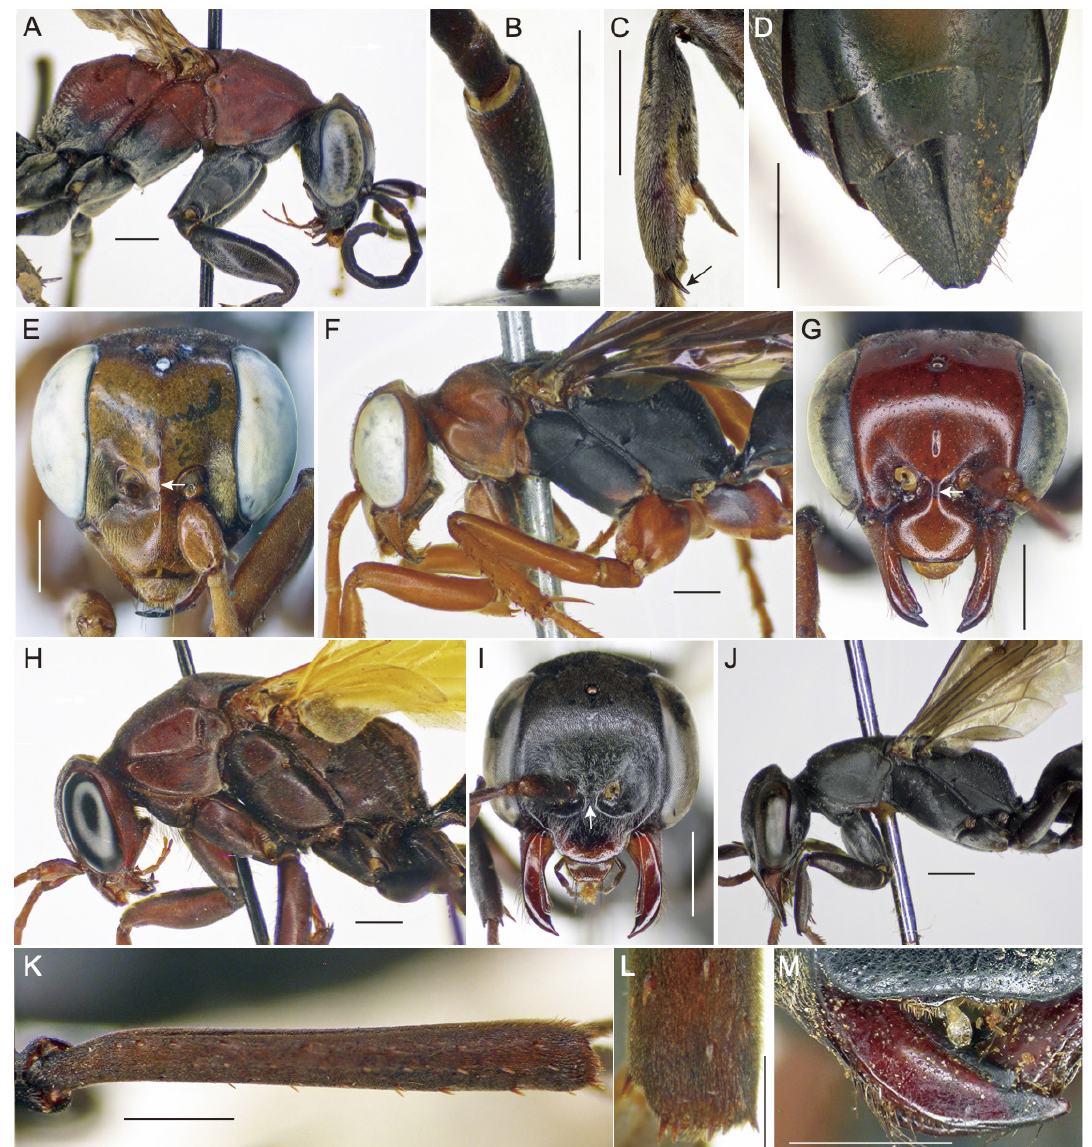
Fig. 2. Females of Ctenocerus Dahlbom, 1845. A–D . C. fasciatus (Smith, 1851) (#3) (NHMUK). E–F . C. flavicauda (Arnold, 1932) (#5) (NHMUK). G–H . C. ramosus Smith, 1865 (#16) (UMUT). I–J . C. lacteipennis (Arnold, 1932) (#12) (NHMUK). K–L . C. robustus (Arnold, 1932) (#14) (NHMUK). M . C. klugi Dahlbom, 1845 (#8) (NHMUK). A, F, H, J . Head and mesosoma, lateral view. B . Left scape, dorsolateral view. C . Right fore tibia, mesial view, arrow points to apicomesial spine on fore tibia. D . Apical part of metasoma, ventral view. E, G, I . Head, anterior view, arrow indicates frontal bridge. K . Left hind tibia, dorsal view. L . Apical part of left hind tibia, dorsal view. M . Mandible, anteroventral view. Numbers in parentheses after species names are specimen numbers in Supp. file 1. Scale bars: A–K, M = 1 mm; L = 0.5